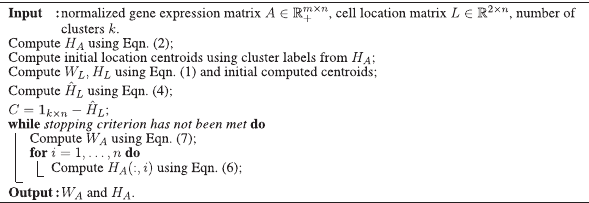
Algorithm 1. scHybridNMF: an algorithm to minimize Eq.